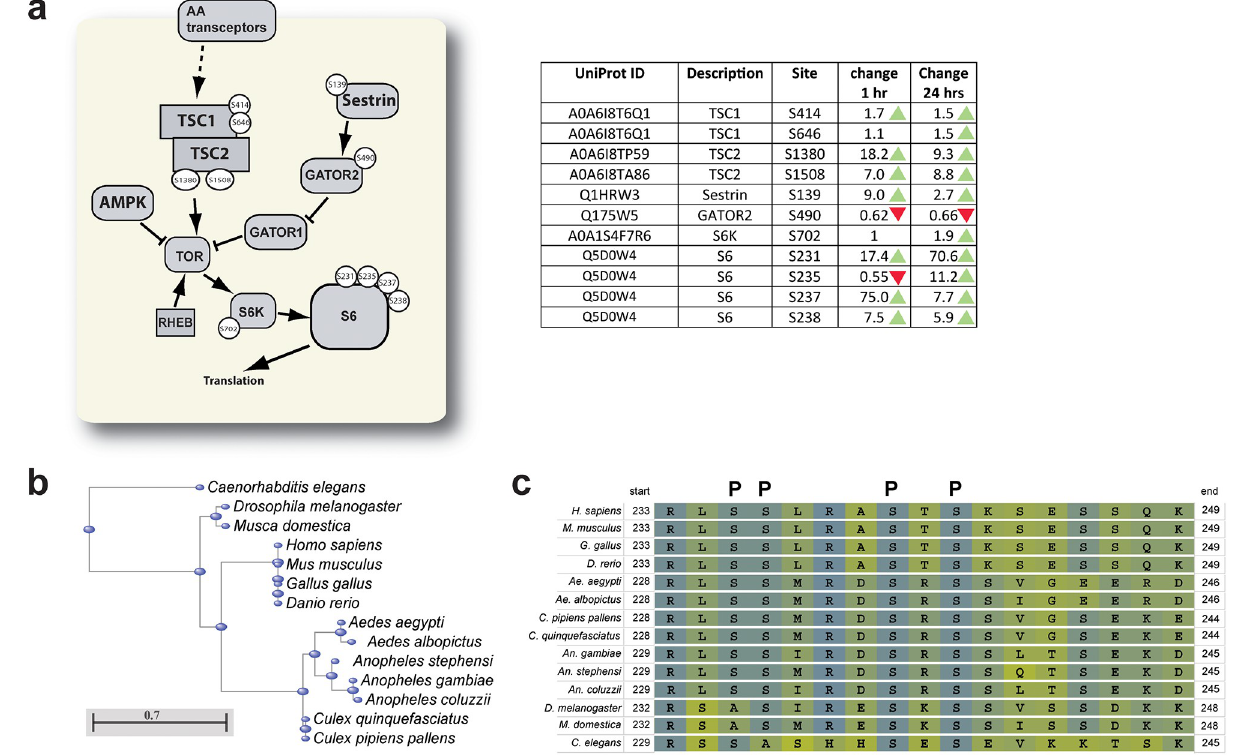
Fig 5. Changes in TOR signaling, and conservation of rps6 phosphorylation sites. a. many proteins involved in Tor signaling underwent changes in phosphorylation after blood feeding. The diagram shows important proteins in the Ae . aegypti Tor signaling pathway conserved in other eukaryotic organisms, with the specific residue(s) with changed phosphorylation state PBM. The table contains more information about each phosphorylated protein, including the Uniprot ID, and the change in phosphorylation of each residue at 1hr PBM relative to unfed, and at 24hr PBM relative to unfed. Green arrowheads represent at least 1.5-fold increased number of phosphorylated residues detected relative to the same position in unfed samples, and red arrowheads represent at least 1.5-fold decreased number of phosphorylated residues detected relative to the same position in unfed samples. b. Neighbor joining tree generated by the COBALT multiple sequence alignment tool ( Papadopoulos & Agarwala, 2007 ), which illustrates the conservation of S6 in several orders of eukaryotes. c. Multiple sequence alignment of a portion of the S6 protein which is enriched in phosphorylation sites. This region contains four serine residues that are phosphorylated in mammalian S6 (marked by “P” above the alignment). All four of these residues are conserved in Ae . aegypti , and three of them (S231, S235, and S237) underwent changes in phosphorylation in MTs after blood feeding.